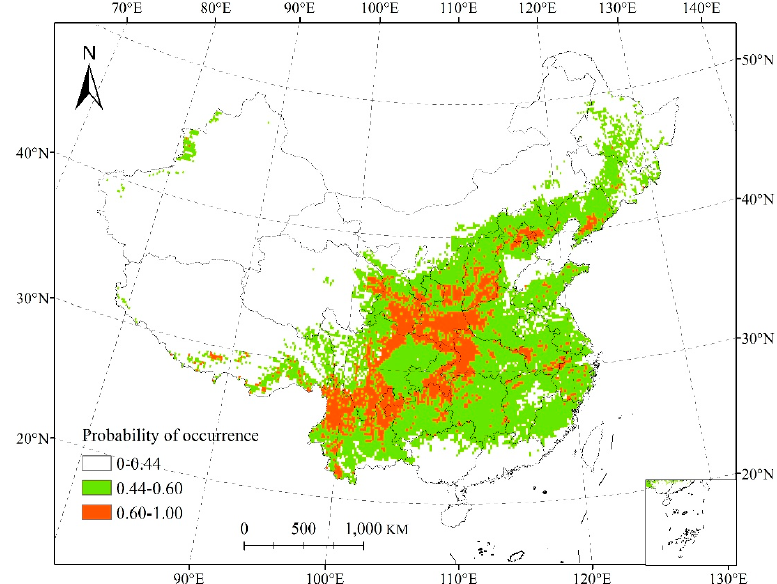
Figure 1. Present potential distribution pattern of Salicaceae plants in China, using the Albers The map was plotted in ArcGIS projection. The map was plotted in ArcGIS v10.2.